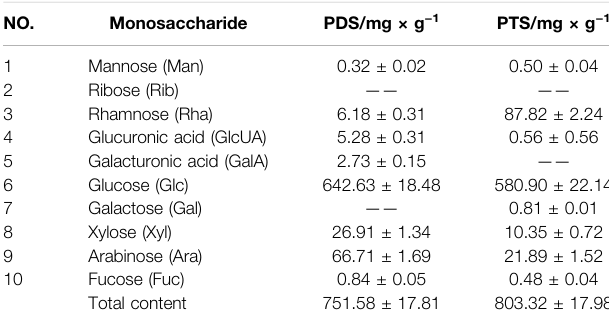
TABLE 2 | Monosaccharide content of PDS and PTS ( ‾ x ± SD, n = 3).